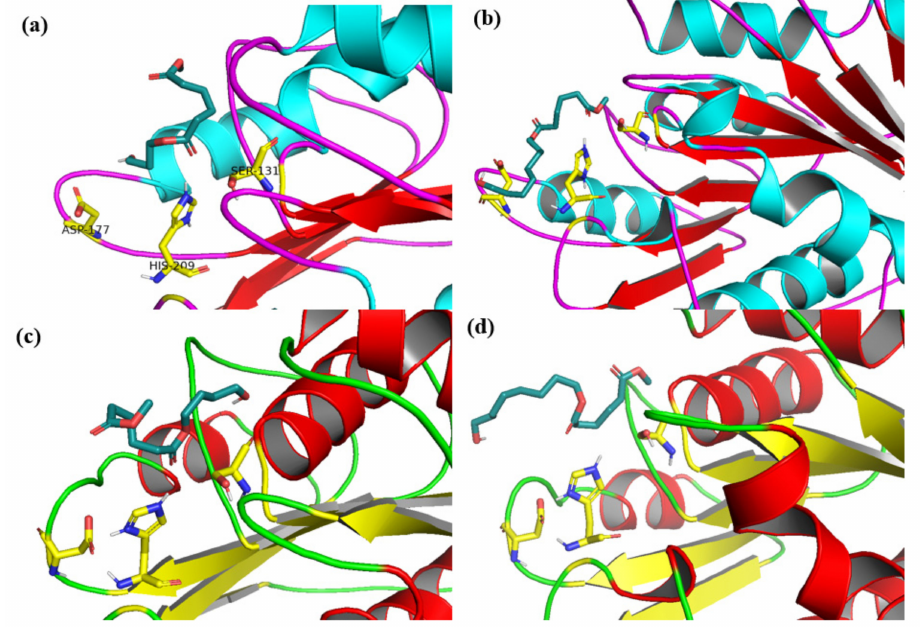
Figure 6. BDO-DMA ( a , c ) and ODO-DMA ( b , d ) substrates docked by Autodock in the active site of Thc_Cut1_PBM ( a , b ) and Thc_Cut1_CBM ( c , d ). The catalytic Ser 131, Asp 177 and His 209 are in yellow, whereas the substrates are